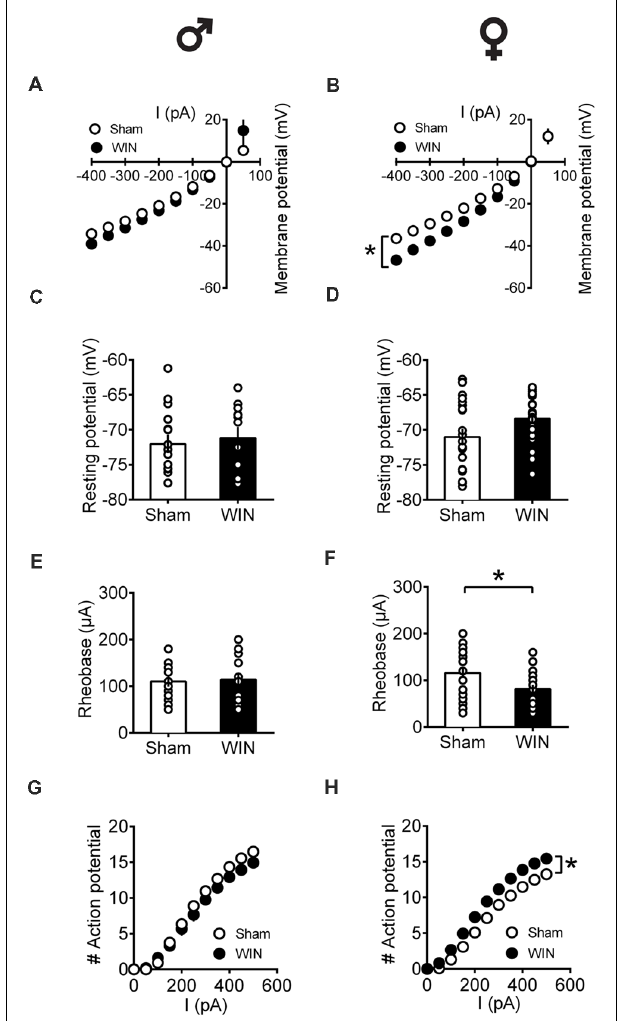
cannabinoid exposure during pubescence. Thus, as females reach puberty before males (Schneider, 2008), we used females at an earlier PND of development than males. The frequency